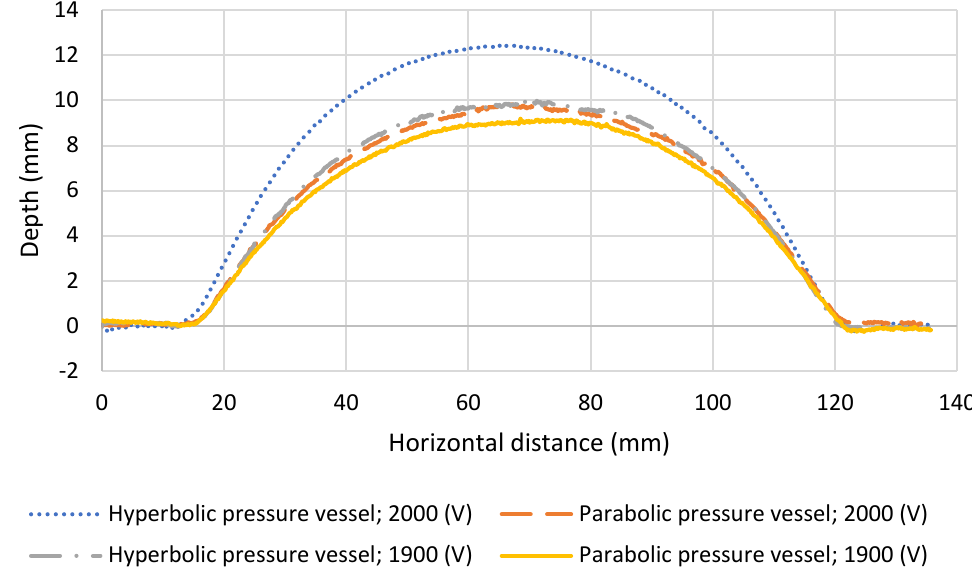
Figure 17. Comparison of pressure vessel shape and charging voltage when an AZ31 plate is sandwiched between auxiliary plates.